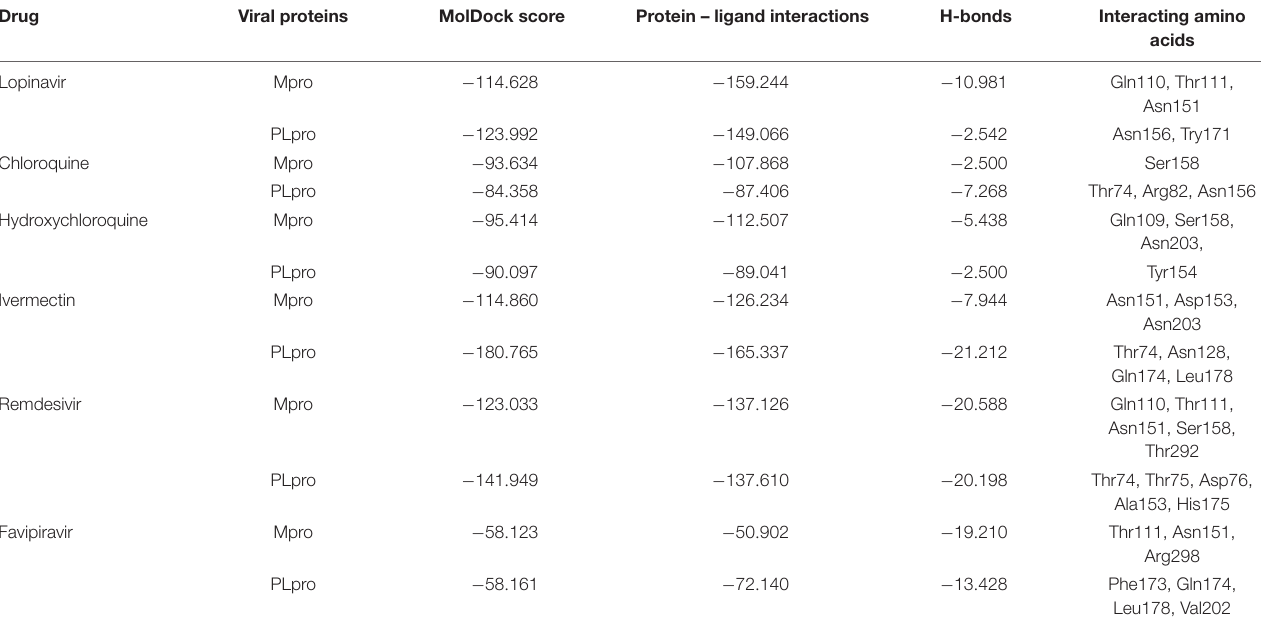
TABLE 3 | Docking of SARS-CoV-2 Mpro and PLpro against different drugs. Drug